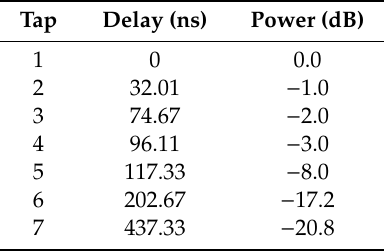
Table 5. Modified EPA delay profile; CFO = 1 kHz; mean = 0.2725, variance = 0.0698.